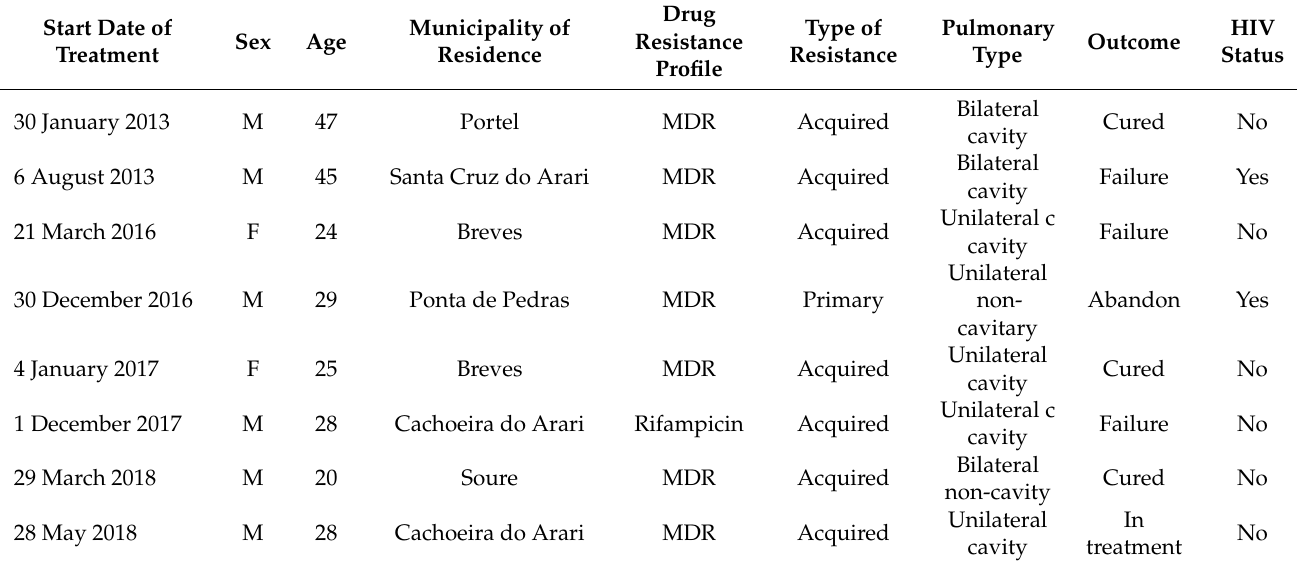
Table 4. First-line drug-resistant tuberculosis cases on Maraj ó -Par á Island and the closure situation. Start Date of Treatment